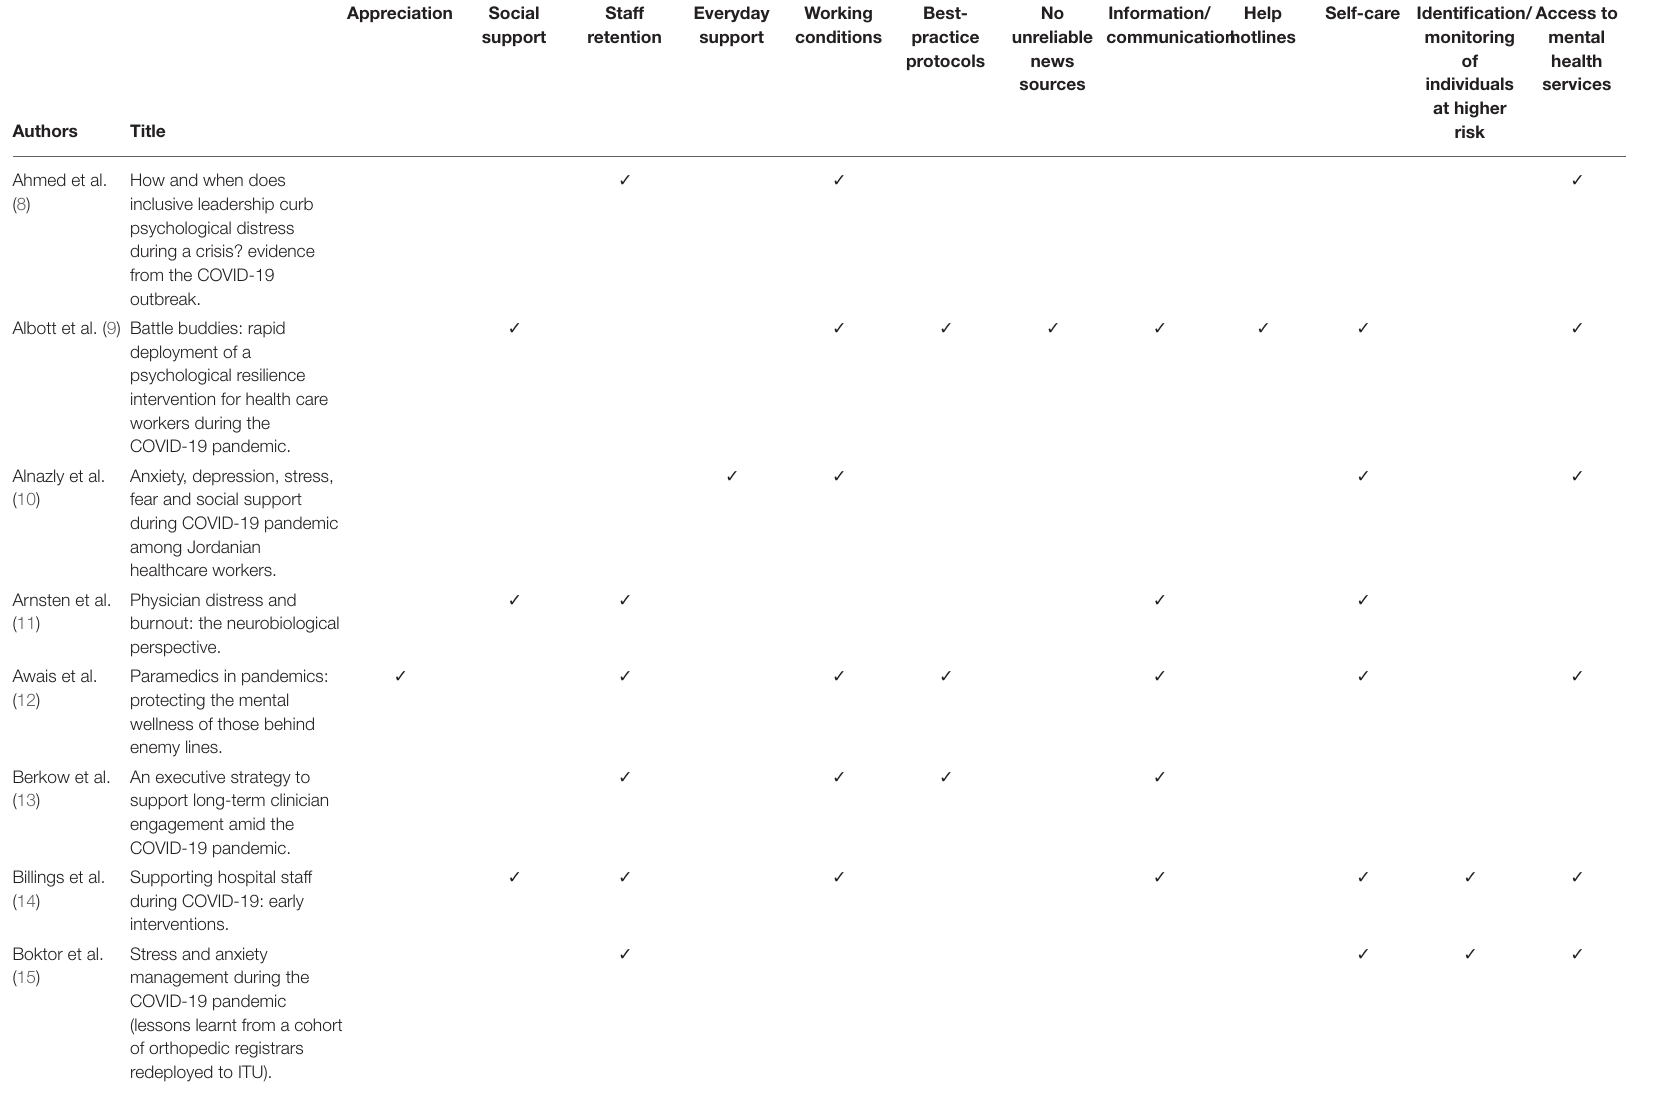
TABLE 2 | Overview of the key topics included in each